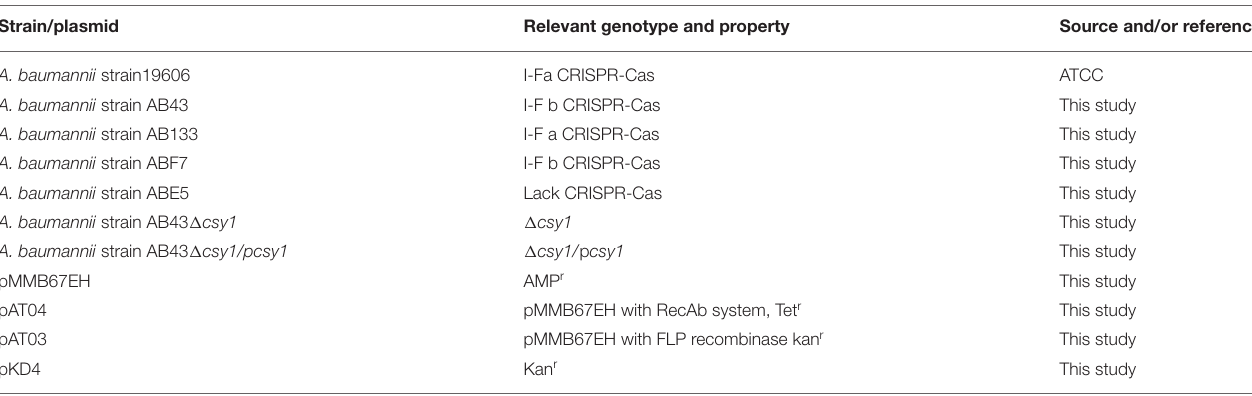
TABLE 1 | Strains and plasmids used in this study.